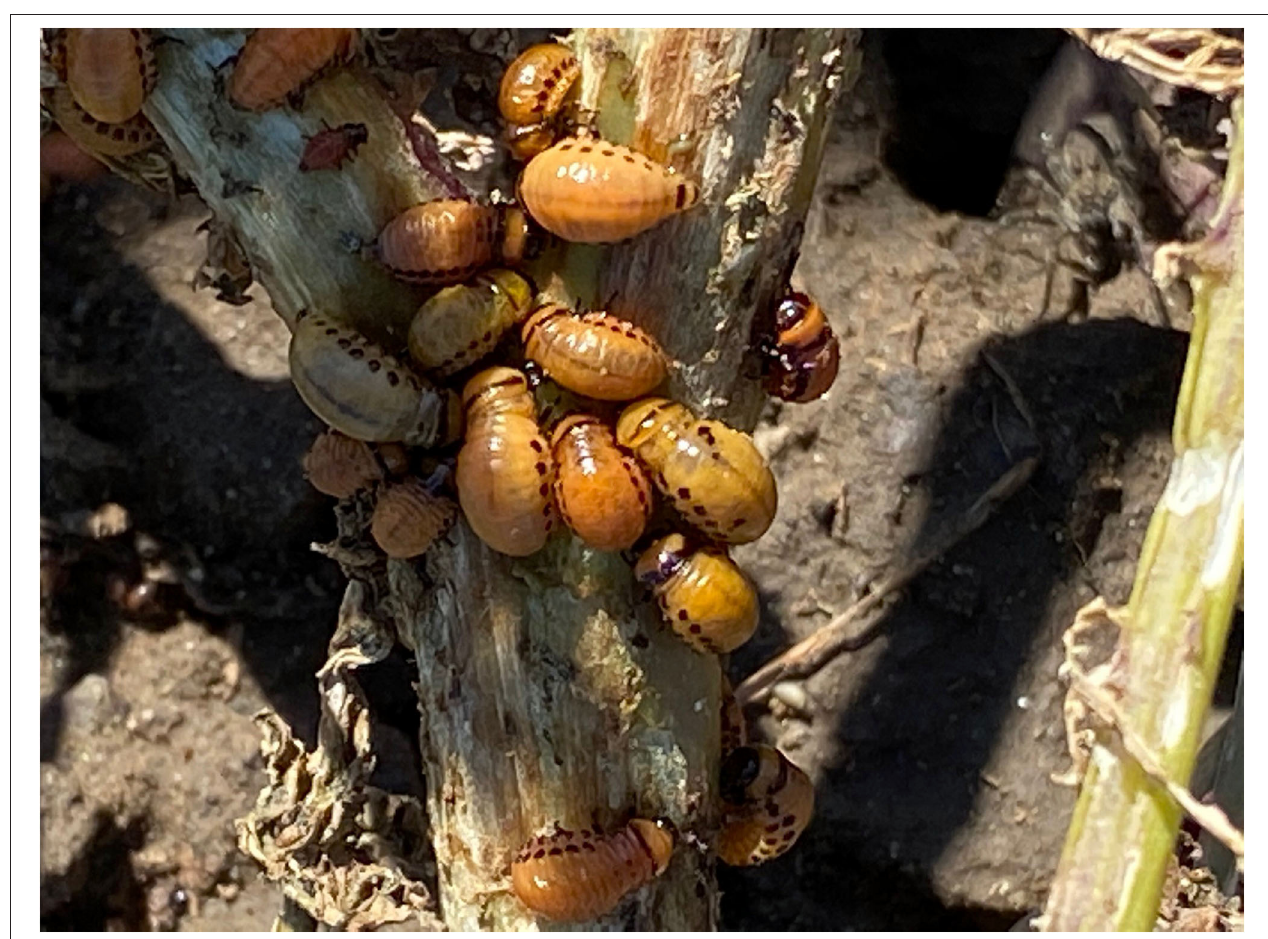
FIGURE 1 | Leptinotarsa decemlineata